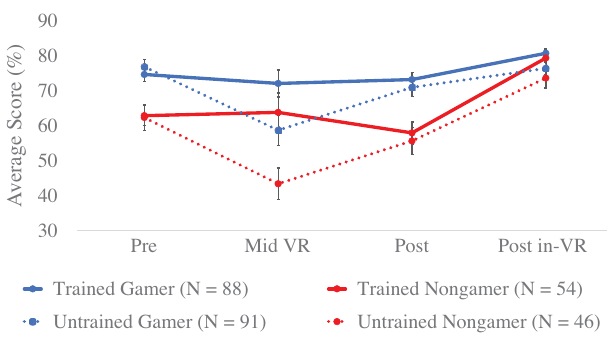
FIG. 7. Average scores at different time points on questions posed in different media, separated by treatment type and gaming experience.